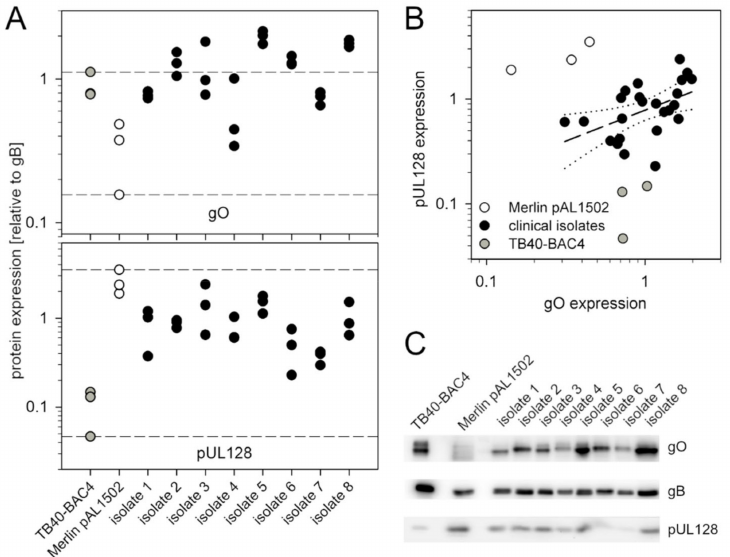
Figure 3. Comparison of various recent clinical human cytomegalovirus (HCMV) isolates and virus strains TB40/E and Merlin regarding the relative abundance of glycoprotein O and pUL128. ( A ) For each isolate or virus strain, three independent lysates of infected cell cultures were analyzed by separation on 10% polyacrylamide gels and subsequent immunoblotting for glycoprotein O (gO), pUL128 and glycoprotein B (gB) using monoclonal antibodies against the respective protein. gB was used as a reference protein, and ratios of gO/gB signals and pUL128/gB signals were used as a readout for the relative abundance of gO and pUL128. Each dot represents one lysate. Dashed lines indicate the upper and lower limits of the values for laboratory strains TB40/E and Merlin. ( B ) Values of the relative abundance of pUL128 and gO were plotted against each other, and for clinical isolates (black dots) a linear regression analysis was performed (dashed line) Dotted lines represent the 95% confidence interval. ( C ) An example of one representative immunoblotting analysis underlying the analyses of ( A , B ) is